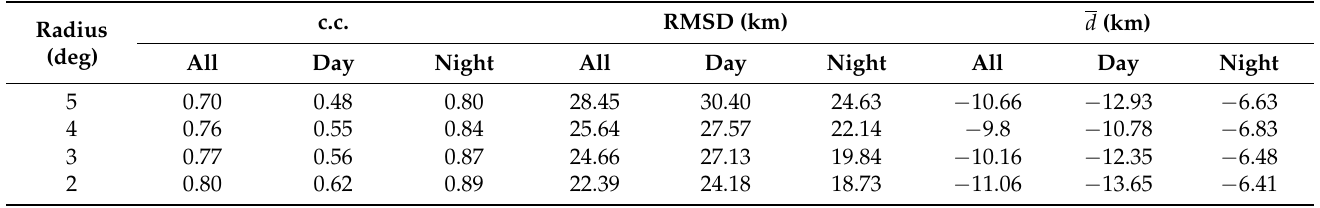
c.c.: Correlation Coefficient, RMSD: Root Mean Squared Deviation,